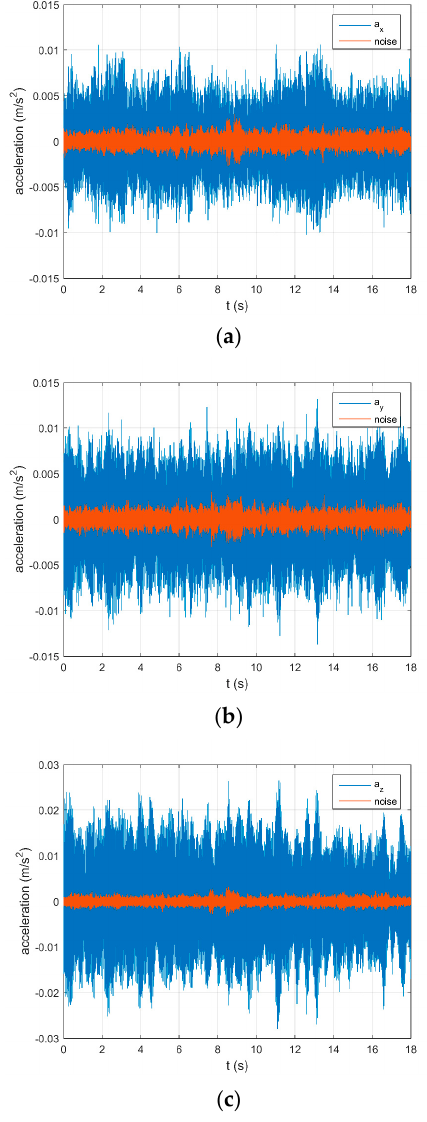
Figure 8. The accelerations of a1 sensor at 2000 rpm. ( a ) a x ; ( b ) a y ; ( c ) a z . The gathered acceleration signals were transformed into displacement signals by quadratic integration, in order to fi t the rigid-body displacement of each optical element, using Equation (17). Then, the image motion at each speed can be calculated by Equation (20). Through Equation (19), it is possible to determine the image motion at each speed, including the image motion at 0 rpm, 500 rpm, 1000 rpm, and 2000 rpm, as shown in Fig- ure 9. The waterfall of the image motion is shown in Figure 10. The picture shows that when the RWA is at 600 rpm, there is a signi fi cant amplitude at 159.8 Hz.